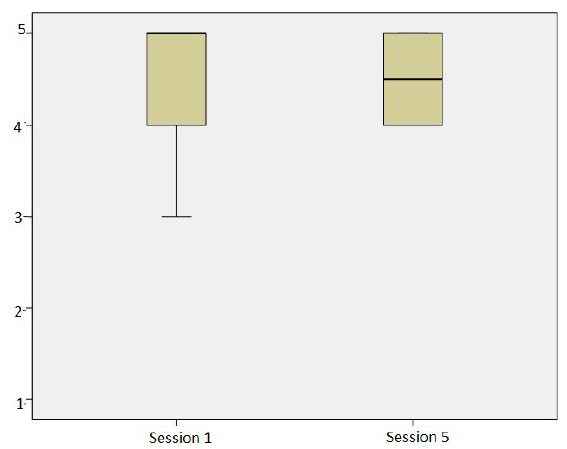
Figure 12. User’s experience of robot’s behavior for AIBO mode (data extracted from questionnaires).